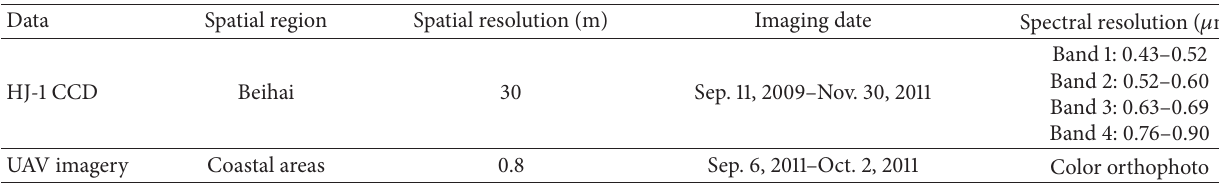
Table 1: Data Information.